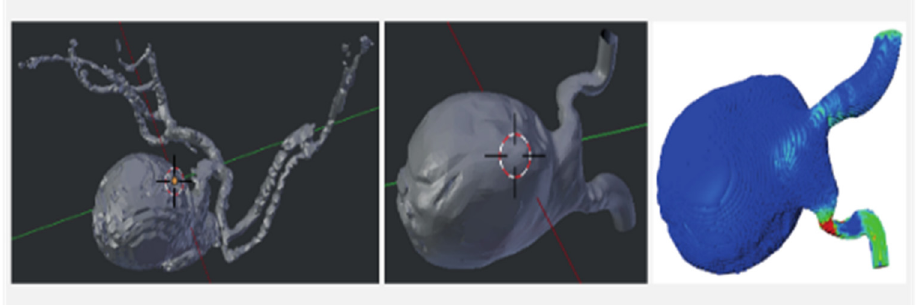
Figure 2. Modeling blood flow. ( left ) 3D view of an IA connected to its local vasculature. The flow in the IA is dominated by vessels directly connected to it ( middle ). A model was made of the geometry to compute the blood flow that develops in this vascular segment ( right ).